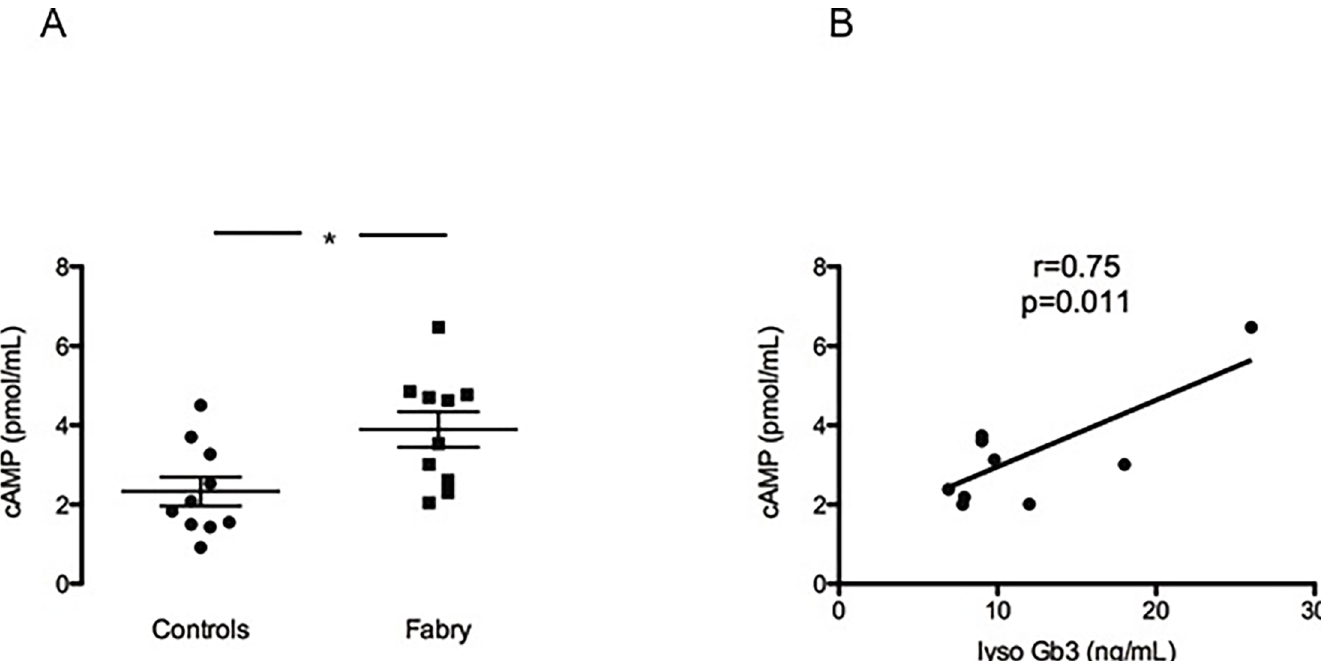
Fig 4. cAMP levels and correlation with LysoGb3. Panel A shows cAMP levels (pmol/mL) in Fabry subjects (Fabry) compared to controls (Controls) Data are shown ± SEM. (cid:3) : p = 0.01. In panel B there is a positive correlation between cAMP levels in Fabry patients and their LysoGb3 levels. r = 0.75, p = 0.011.